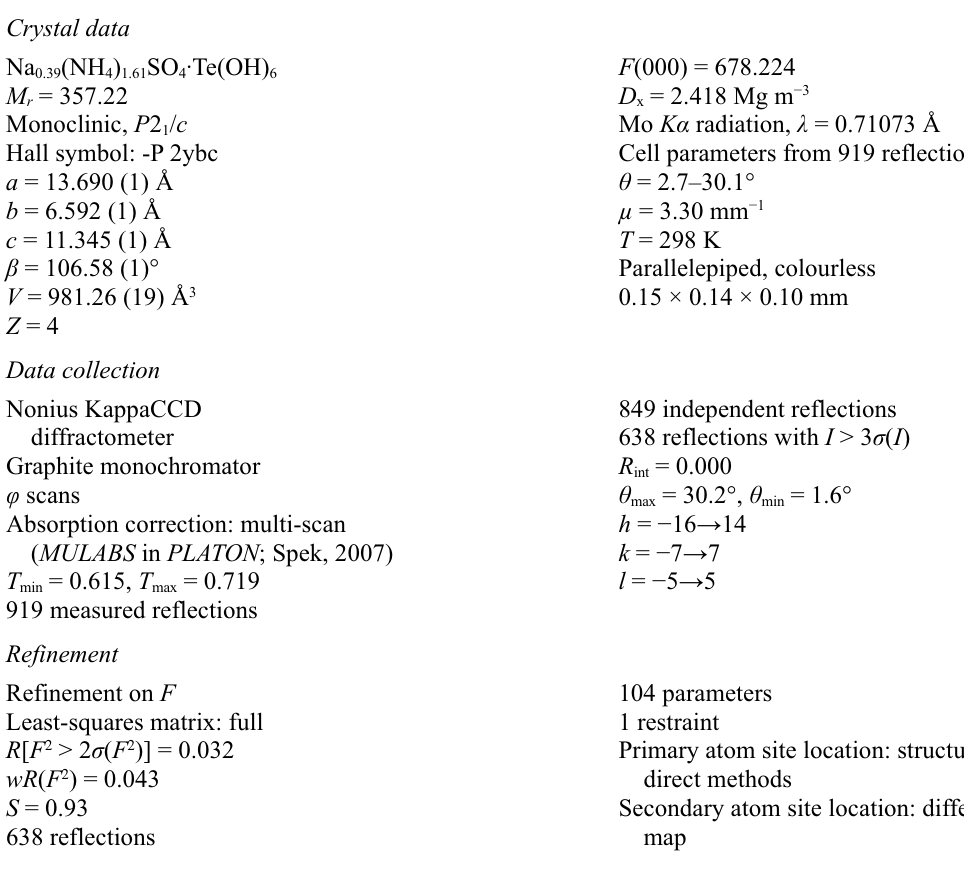
Figure 3 Crystal structure of Na sodium ammonium sulfate–telluric acid